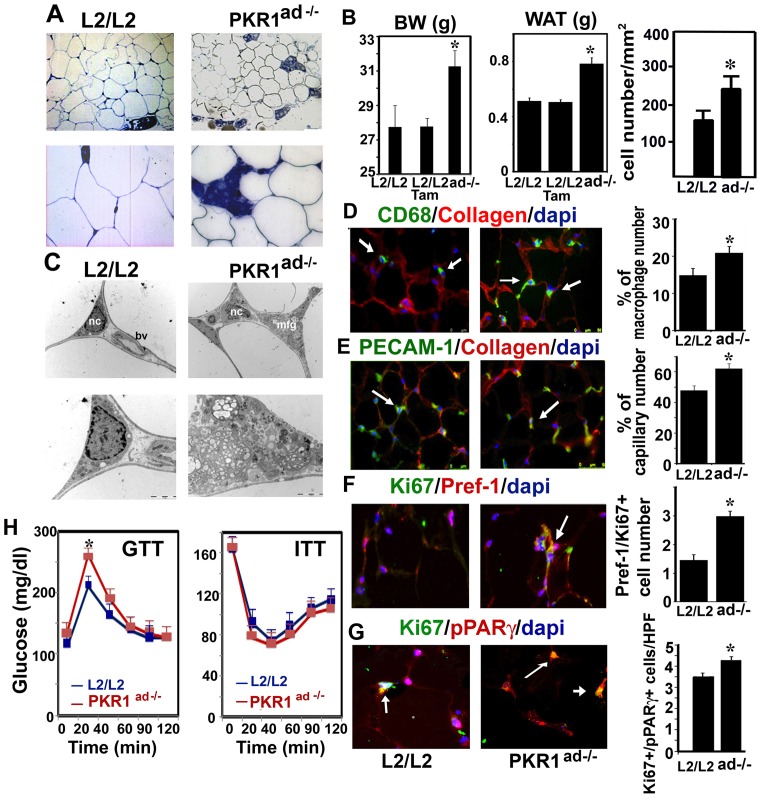
Abdominal obesity in PKR1ad−/− mice is due to preadipocyte proliferation and differentiation.A) Representative illustration of semi thin analyses of adipose tissues derived from control (L2/L2) and PKR1ad−/− mice. Blue shows macrophage accumulation. B) Body (g) and WAT weight (g), and adipocyte number of the PKR1ad−/− and L2/L2 mice (*p<0.05, n = 6). C) Representative illustration of electron microscopic analyses of adipose tissues derived from PKR1ad−/− and L2/L2 mice, showing macrophage deposition in PKR1ad−/− mice. D) Macrophage specific CD68 staining and quantification of macrophages on cryosectioned adipose tissues derived from PKR1ad−/− and L2/L2 mice (*p<0.05, n = 20 HPF, ×40 objective). E) Illustration and histogram shows the PECAM-1 staining and capillary formation changes between the adipose tissues of PKR1ad−/− and L2/L2 mice (*p<0.05, n = 20 HPF, ×40 objective). F) Representative illustration and quantification of pref-1+/Ki67+ positive cells (orange) and dapi positive total cells (blue) in adipose tissue of PKR1ad−/− and L2/L2 mice (*p<0.05, n = 20, HPF, ×40 objective). G) Representative illustration and quantification of PPARγ+/Ki67+ positive cells (orange) and PPARγ/dapi positive total cells (violet) in adipose tissue of PKR1ad−/− and L2/L2 mice (*p<0.05, n = 20 HPF, ×40 objective). H) GTT and ITT in 24 weeks old mice (*p<0.05, n = 6).